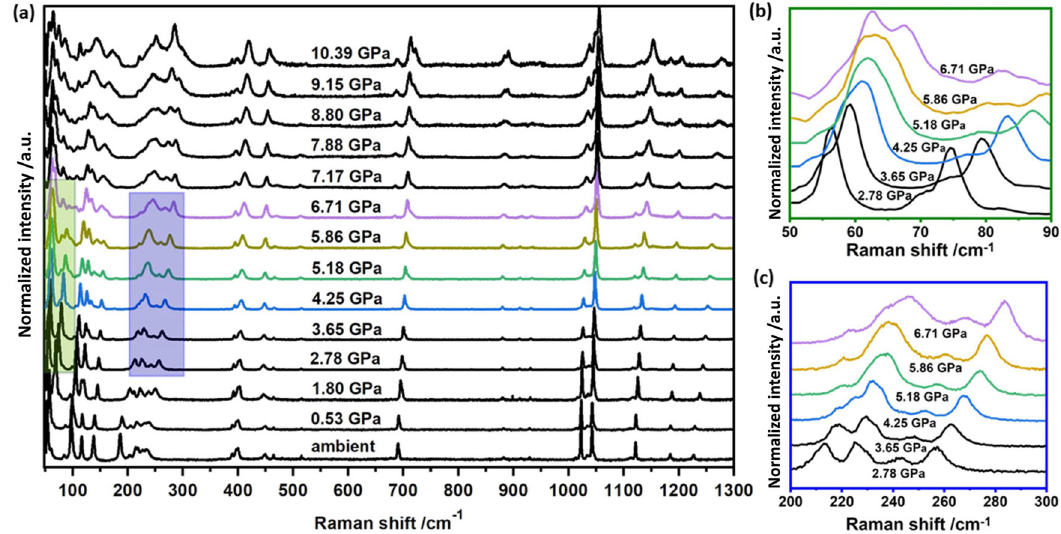
Fig. 3 High-pressure Raman spectra collected for a polycrystalline sample of (1). a Raman spectra collected across complete pressure range; b – c magni fi cation of selected regions which exhibit band splitting across the phase transition. Full spectra are given in Supplementary Note